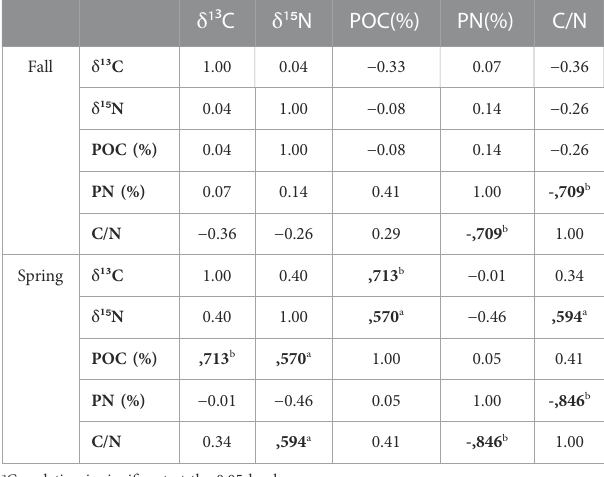
(Table 2; Figure 2). PN (%) and C/N of POM varied signi fi cantly among sites ( r 2 = 0.623, p < 0.001 and r 2 = 0.556, p < 0.001,